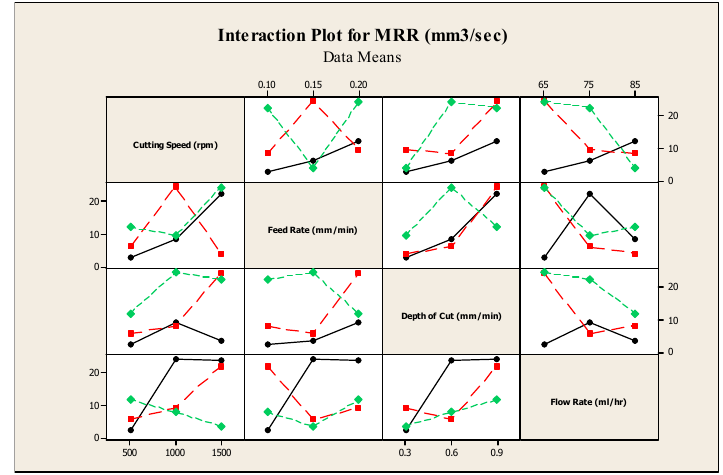
Figure 7. Interaction plot for material removal rate. Metals 2020 , 10 , x FOR PEER REVIEW